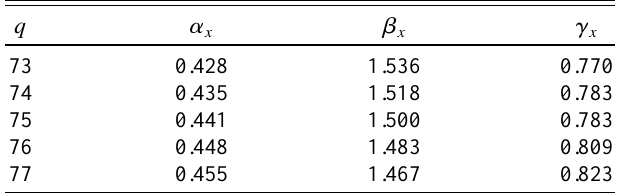
TABLE IV. Four types of errors and their tolerable amplitudes.